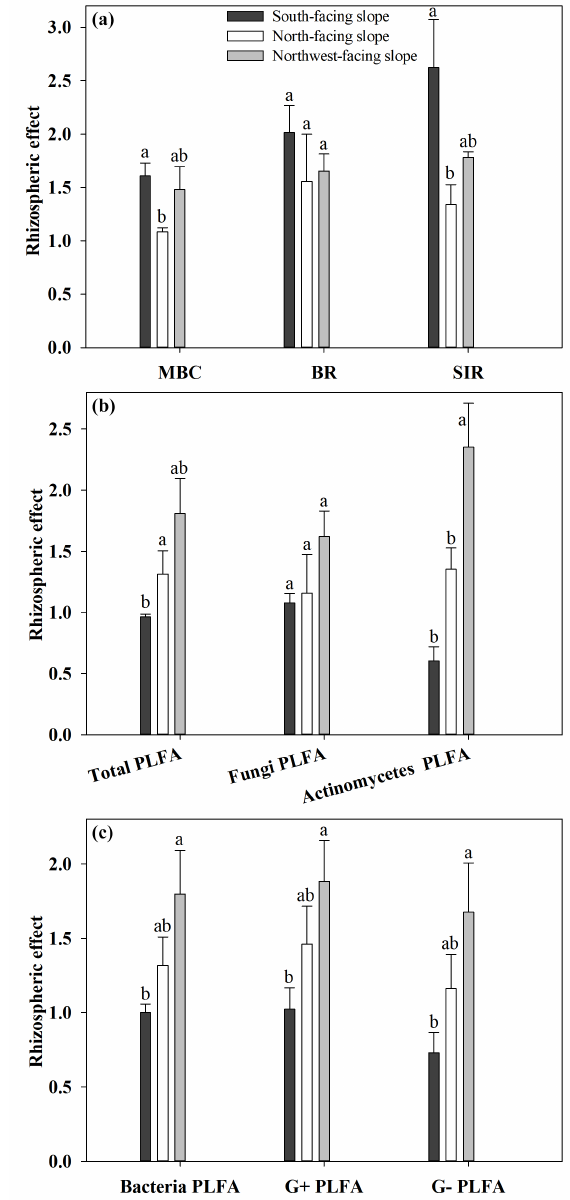
Figure 2. The rhizospheric effects of MBC, BR, SIR, and PLFA contents. Error bars are standard errors ( n = 3). Different letters above the bars indicate significant differences at P = 0 .